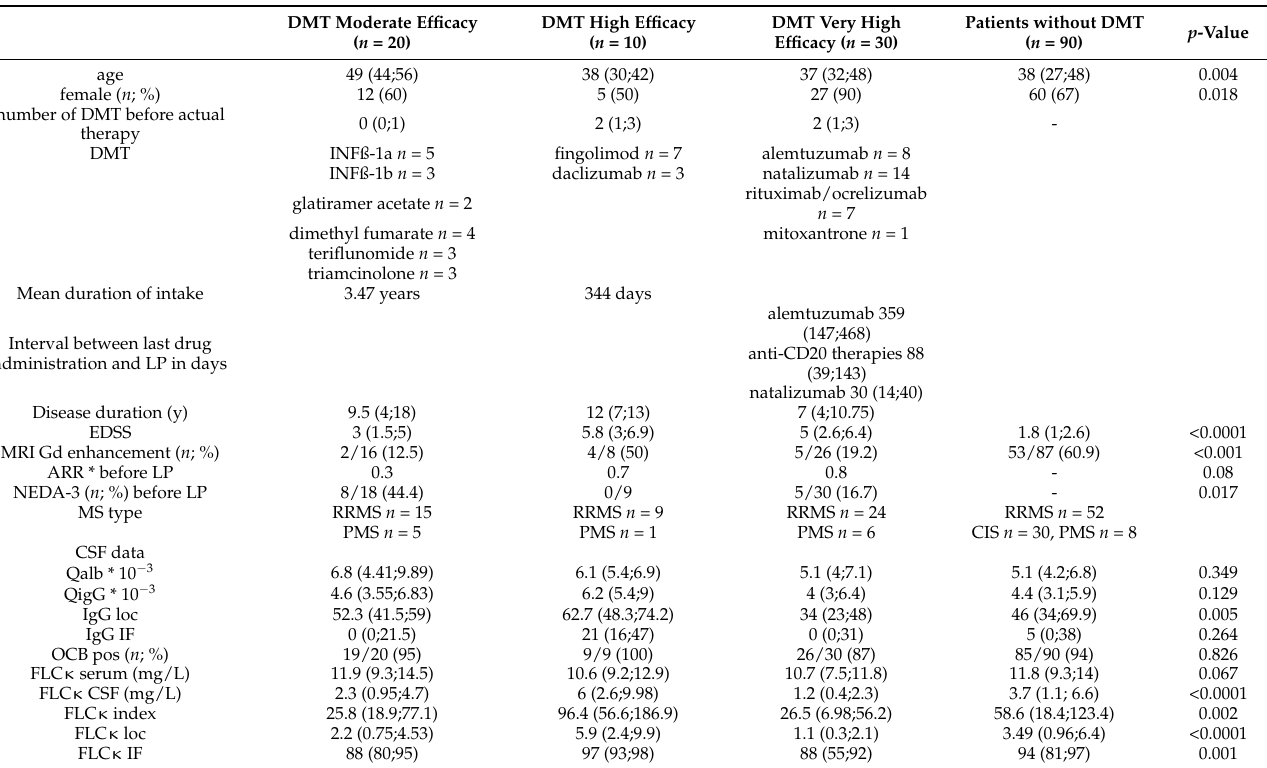
Table 1. Clinical and CSF